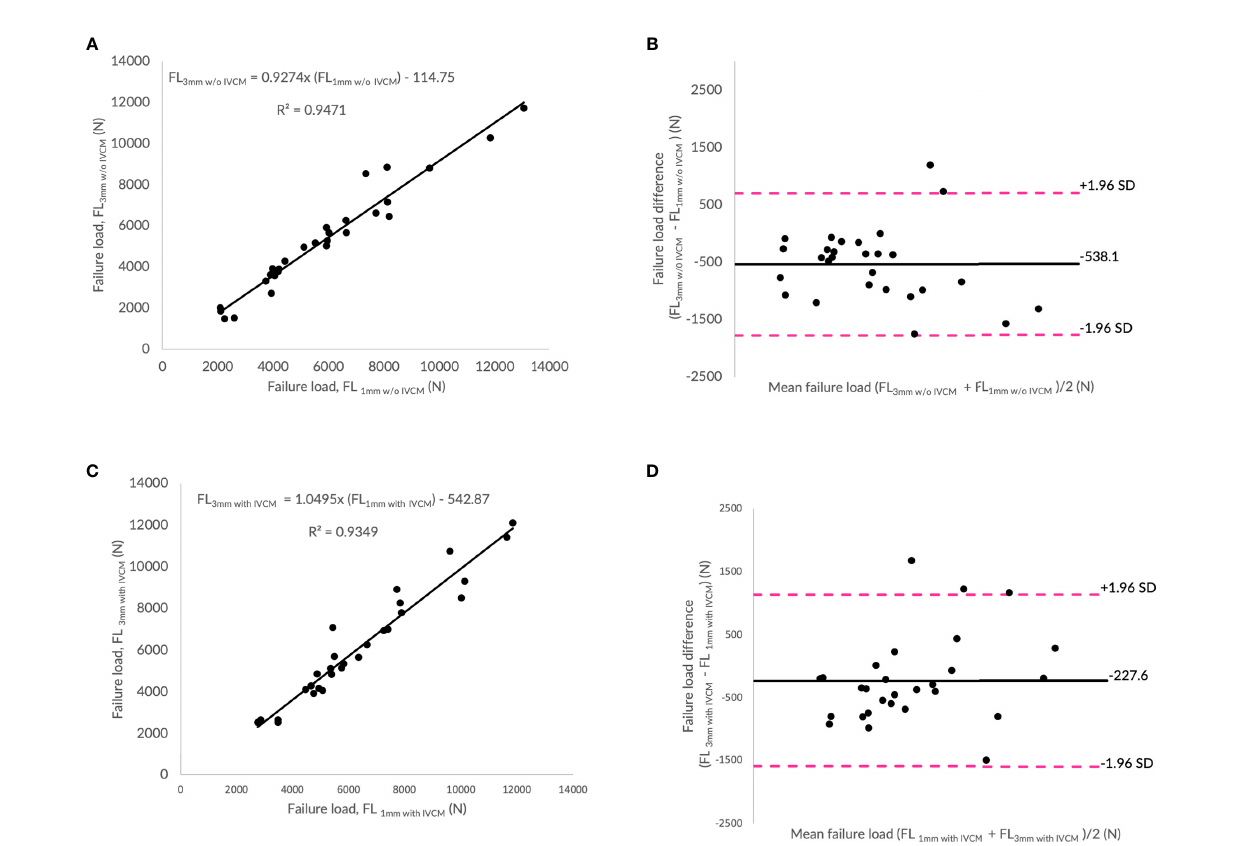
FIGURE 4 | Effect of slice thickness on fi nite element (FE)-predicted failure load values. (A) Correlation plot between FE-predicted failure load values for 1 and 3mm without intravenous contrast medium (IVCM), (C) correlation plot between FE-predicted failure load values for 1 and 3mm with IVCM, and (B, D) Bland Altman plots representing the mean of FE-predicted failure load values versus difference between them in with and without IVCM scan settings, respectively. Horizontal lines represent mean and dashed line ±1.96 standard deviation. FL represents FE-predicted vertebral failure load (N).